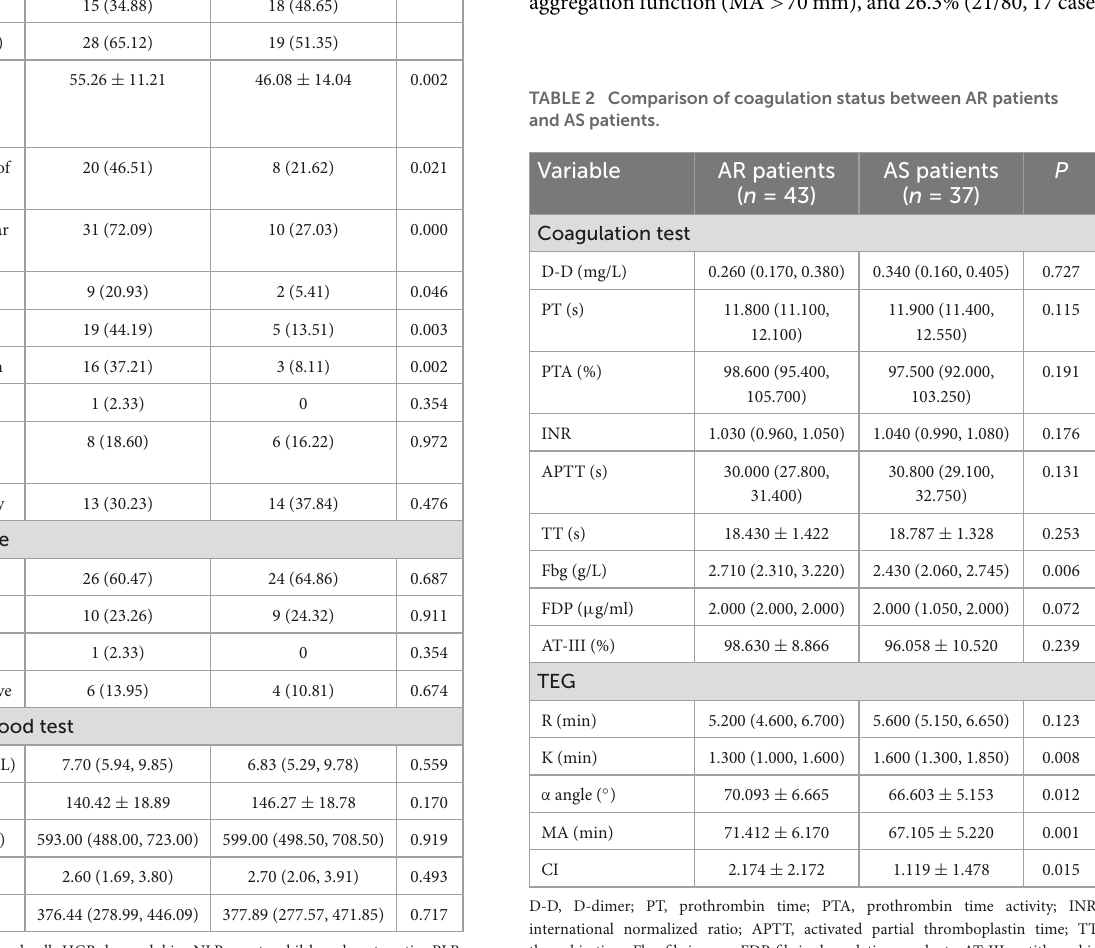
between AR patients and AS patients